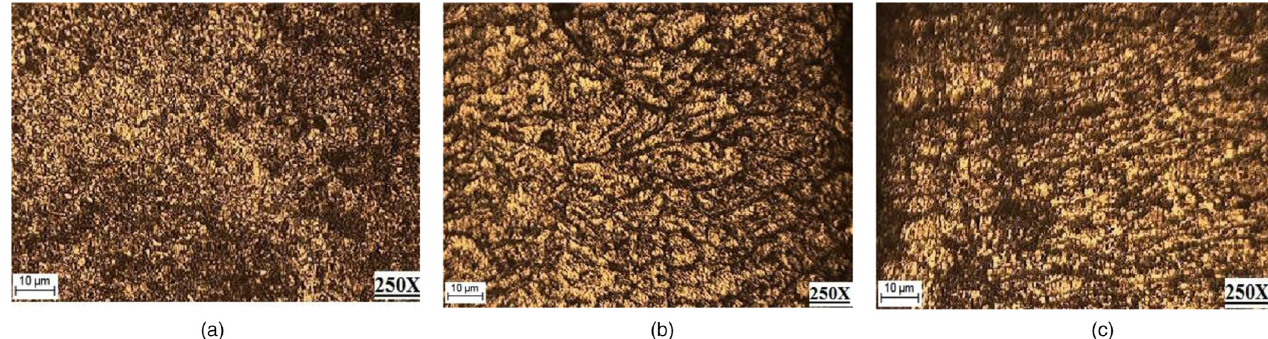
Fig. 3. Grain structure of 8 mm Tin castings for interior, middle as well as external surfaces for speeds of 650rpm. (a) 650 rpm interior surface. (b) 650rpm middle surface. (c) 650 rpm external